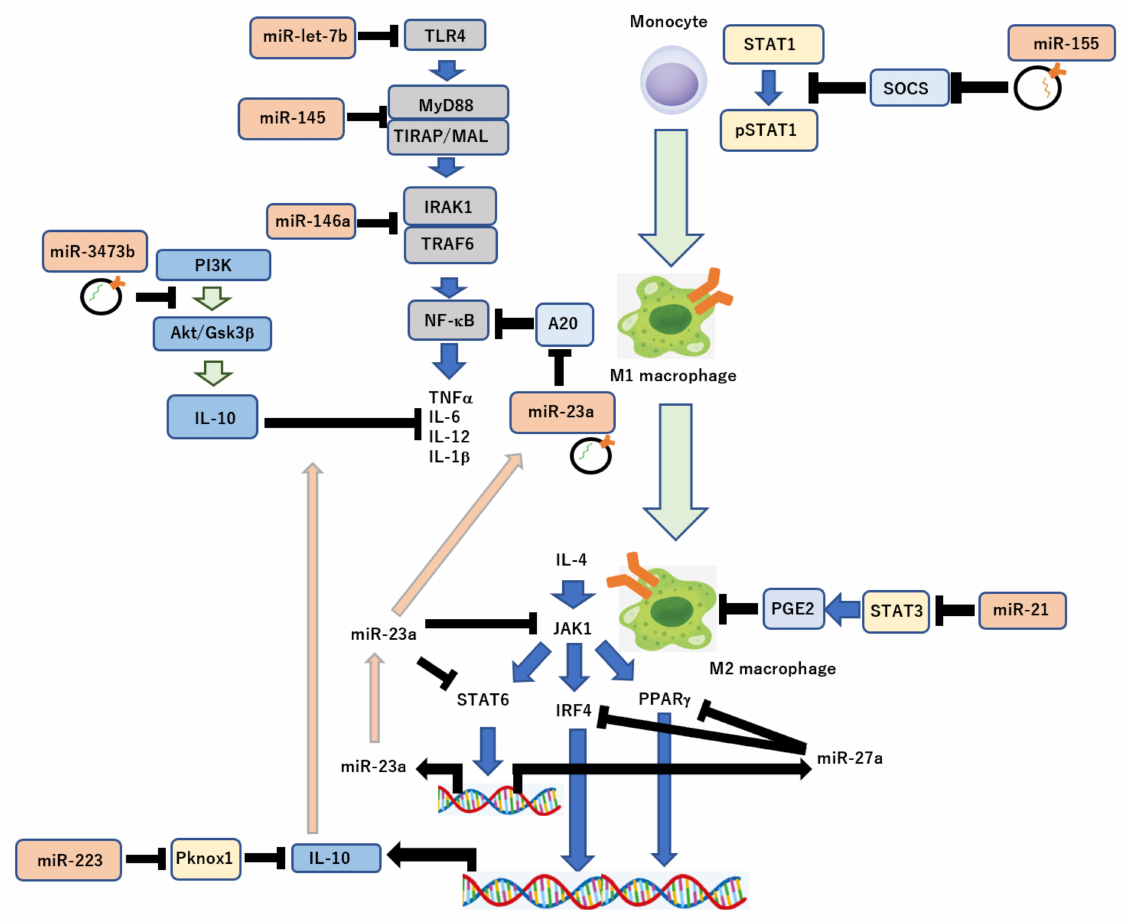
Figure 2. Modulation of immune response by miRNAs. Polarization of macrophages, M1 to M2, differentiated from monocytes, regulated by some molecular pathways, including NF-kB, STAT1, STAT3, and PI3K/Akt pathways, via post-transcriptional regulation by miRNAs, such as miR-155, miR-21, miR-let-7b, miR-145, miR-146a, miR-3473b, miR-23a, and